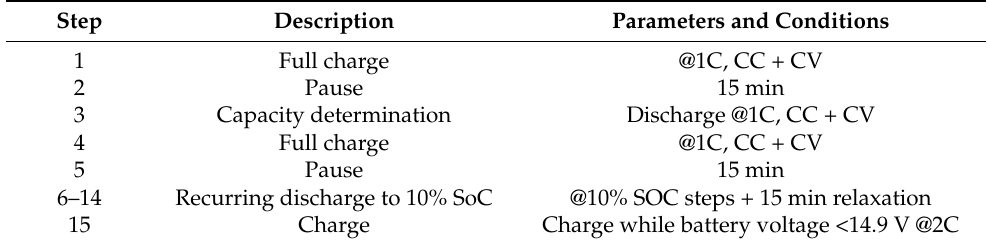
Figure 3. The testing procedure consists of different steps that can be seen over time: voltage curve of the battery module in the test (blue); current curve (red) of the battery module in the test. Table 1. Testing procedure steps to evaluate the capacity and inner resistance of the battery modules at different SOCs.